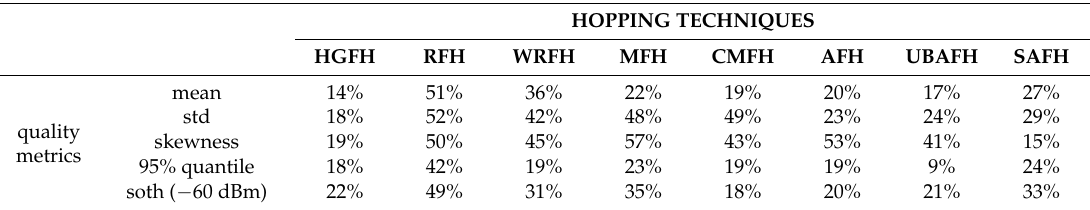
Table 5. Overall PER with w PER = 0.5 and w DIST =